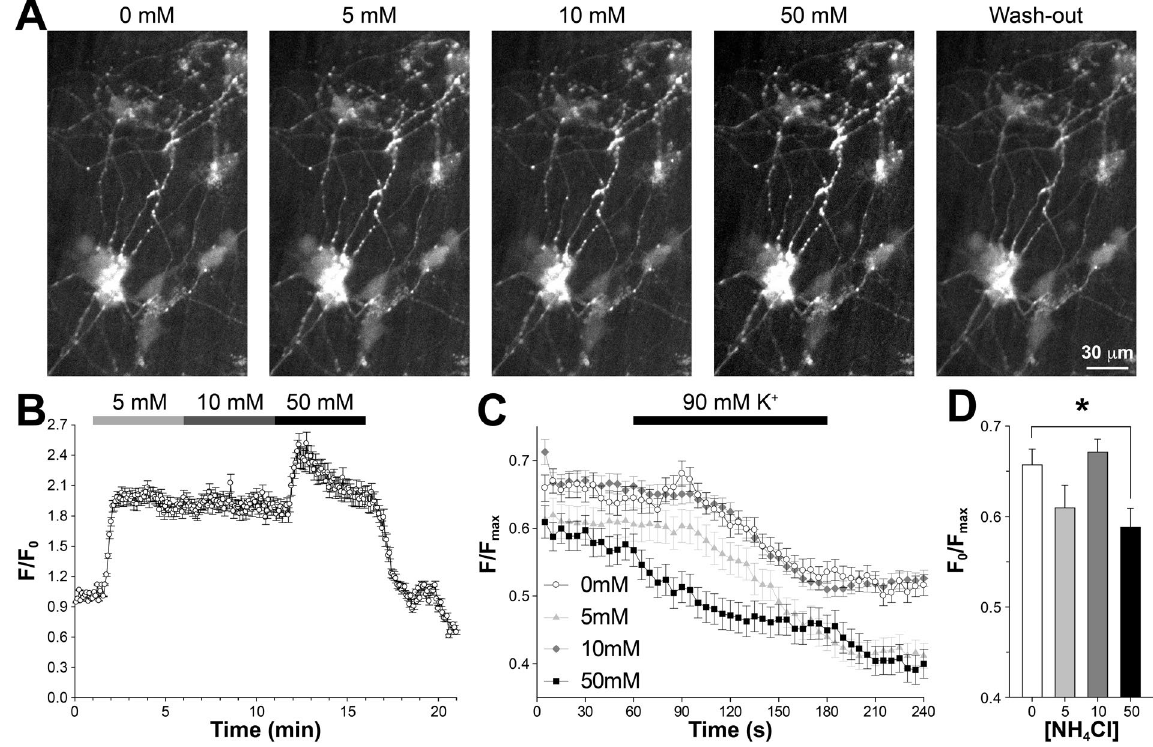
Figure 4. Effects of NH 4 Cl on SypHTm – labeled SVs. ( A ) Sample images of neurons transfected with SypHTm construct and exposed to various concentrations of NH 4 Cl. ( B ) Averaged time-course of the SypHTm fluorescence change (n = 300 randomly selected synaptic boutons from 6 independent trials), reflecting the de-acidification that SypHTm experiences. There was a substantial and sustained increase of fluorescence in 5 mM NH 4 Cl (~100%) but little change upon 10 mM NH 4 Cl, and a further increase (~60%) upon 50 mM NH 4 Cl application. Final wash-off caused two-phase fluorescence decrease below the initial baseline. ( C ) The relative change of SypHTm fluorescence in response to 90 mM K + stimulation after cells’ pretreatment with 0, 5, 10 and 50 mM NH 4 Cl for 5 minutes and washout for another 5 minutes. SypHTm fluorescence increase only occurs in 0 mM group (for each group, randomly selected 35 ROIs/FOV and 3 FOVs). For every ROI, F max (used as 1.0 for normalization) is defined as the fluorescence intensity difference between 50 mM NH 4 Cl and pH 5.5 Tyrode’s solution, both of which were applied sequentially at the end of imaging. ( D ) For those ROIs, the average SypHTm fluorescence before 90 mM K + stimulation (F 0 ) is normalized to F max . Only the 50 mM NH 4 Cl pretreatment caused a significant decrease ( p < 0.05, ANOVA and Student’s t